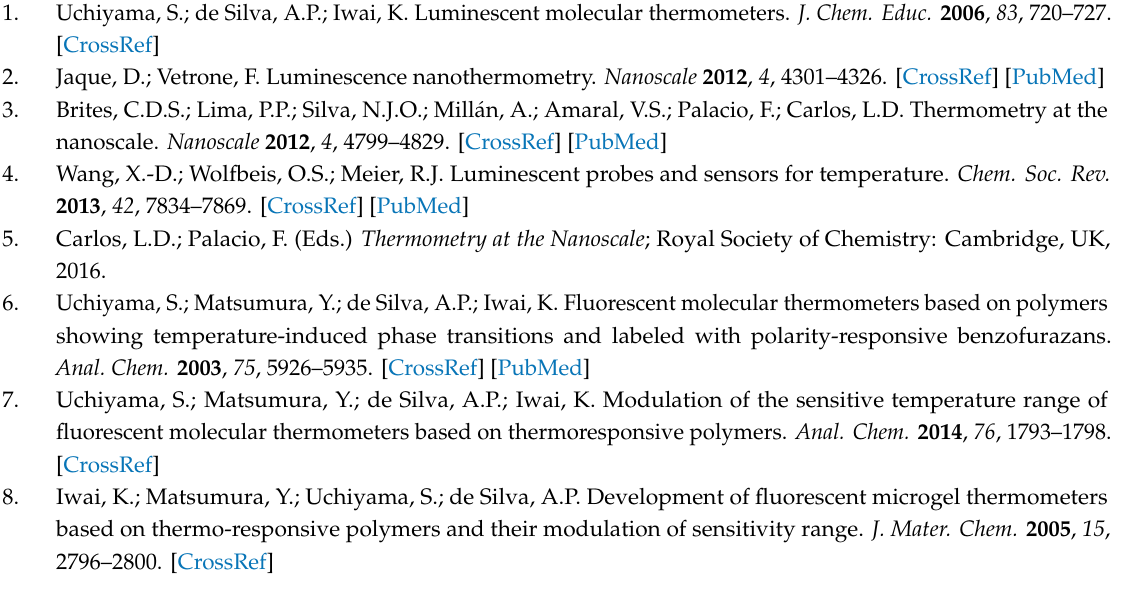
Figure S1: 1H-NMR charts of NANOGEL- 1 ~ 6 , Figure S2: E ff ects of the KCl concentration on fluorescence responses of NANOGEL-3 as a representative. The fluorescence intensity is normalized at 25 ◦ C. The samples were excited at 456